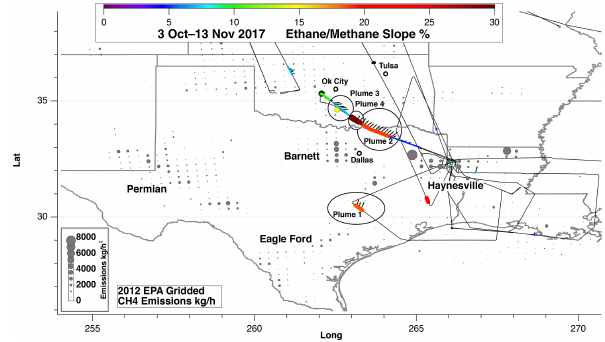
Figure 11. Ethane–methane slopes over the southeast during the October–November 2017 time period showing three plumes with high ethane–methane slopes. The wind directions along the flight tracks are indicated by arrows (the wind speeds, WNS, are multi- plied by 3 for emphasis). The four major shale plays in this region are indicated along with the 2012 EPA gridded methane emission rates in the gray-filled circles, which are sized by their emission